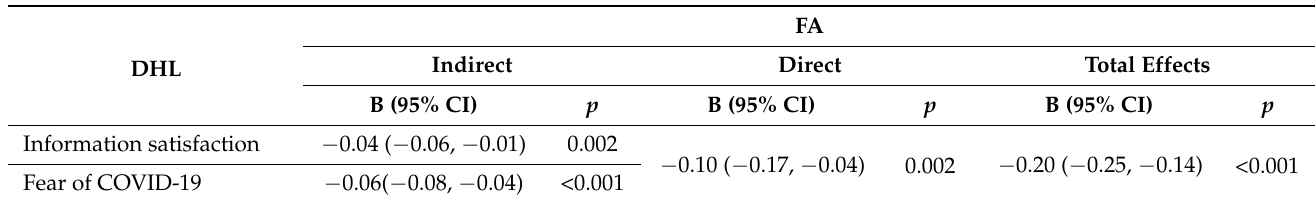
Table 4. Mediating impacts of information satisfaction and F-CoV on the association between DHL and